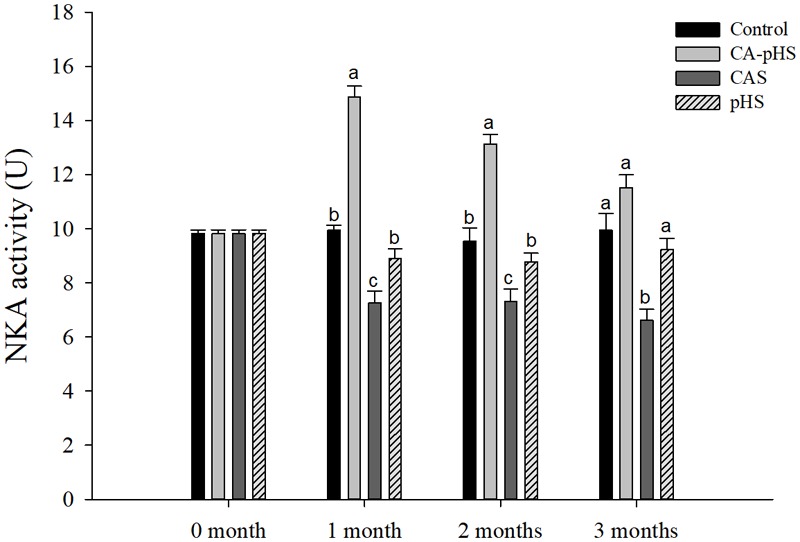
Juvenile of S. constricta Na+/K+-ATPase (NKA) activity levels in the long-term toxicity test. Bars (mean ± SE, n = 3) with different letters denote significant differences (p < 0.05) among the four groups in each month. The letters “ns” indicate insignificant difference among the four groups in each month.